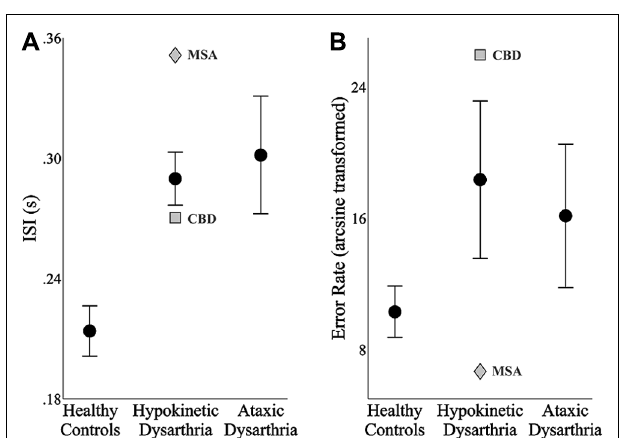
FIGURE 1 |An example of the graphical user interface for processing speech acoustic data from each trial. (A–E) The display depicts the microphone signal (A) , the pre-emphasized microphone signal (B) , changes in spectral energy related to vowels (C) , stops and affricates (D) , and fricatives (E) . Lastly, the panel (F) depicts of a